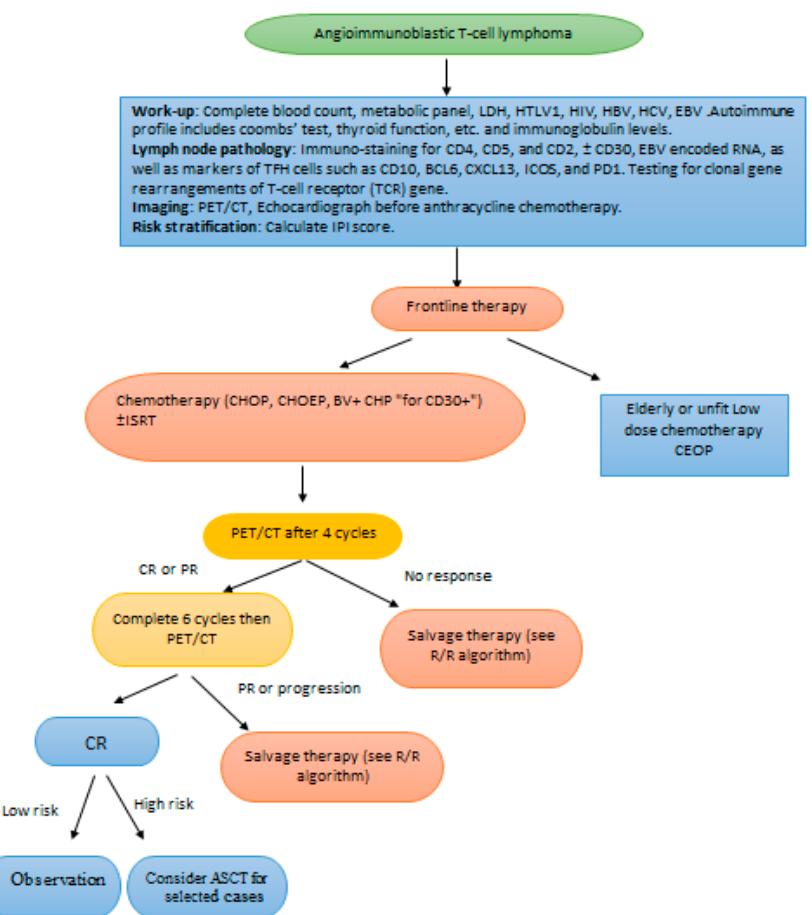
Figure 1. Suggested algorithm of diagnosis and frontline therapy of AITL. Notes: This algorithm is proposed to guide therapy in AITL. ASCT in CR1 is to be offered in selected patients. Abbreviations: AITL, angioimmunoblastic T cell lymphoma; PFS, progression free survival; OS, overall survival; CR, complete remission; PR, partial remission; R/R relapsed/refractory; ASCT, autologous stem cell transplantation; ISRT, involved site radiation; C cyclophosphamide; E etoposide; H anthracycline; BV brentuximab vedotin; O oncovin; P